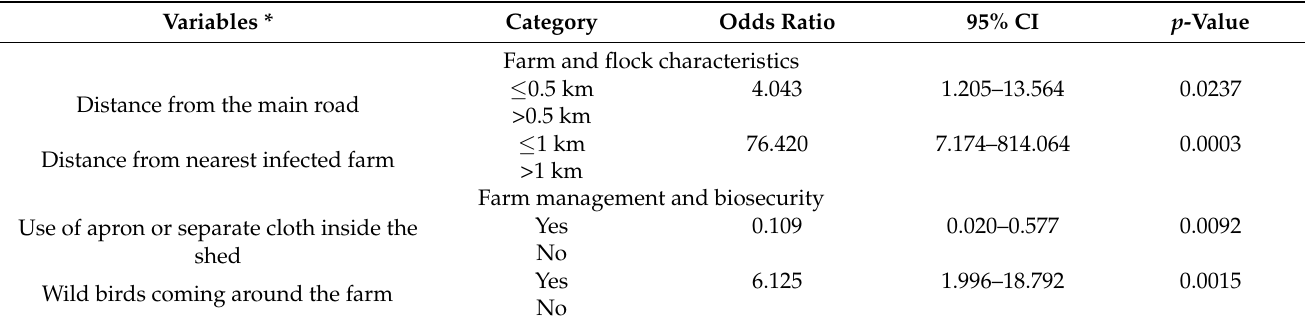
Table 2. Results of multivariable logistic regression analysis of risk factors associated with avian influenza subtype H9 outbreaks in poultry farms of central lowland